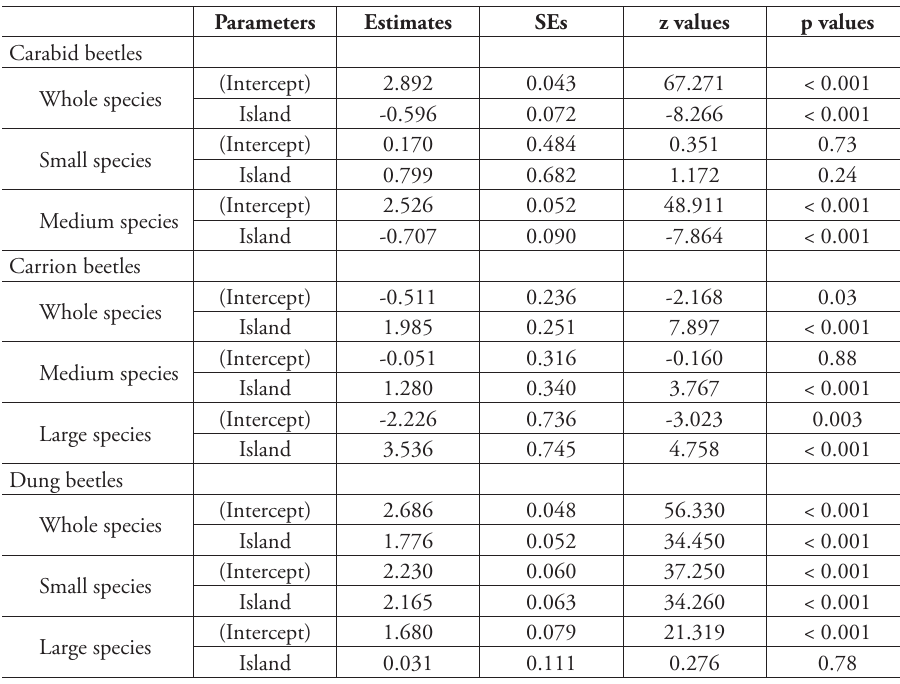
Table 1. Estimates of parameter differences between sites (reference = lakeshore site, i.e., coefficients of lakeshore site are zero), standard errors (SEs), z values, and p values in generalized linear models of each of taxonomic group and body size group abundance. Bold letters represent p <